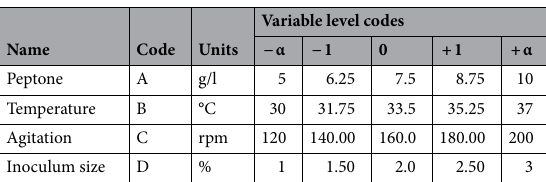
Table 5. Experimental ranges of the most significant independent variables used in response surface method